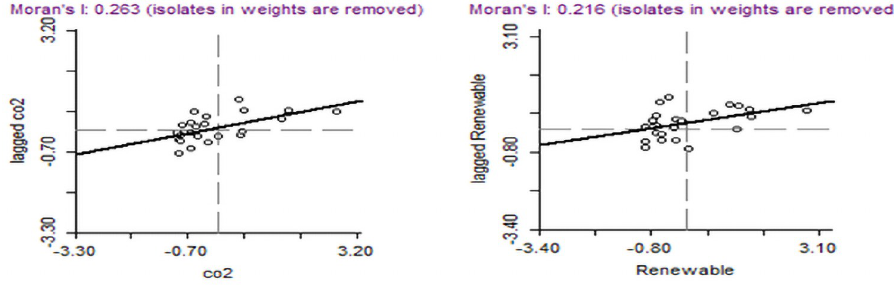
Fig 2. Moran’s I statistics for CO 2 emissions per capita and renewable energy per